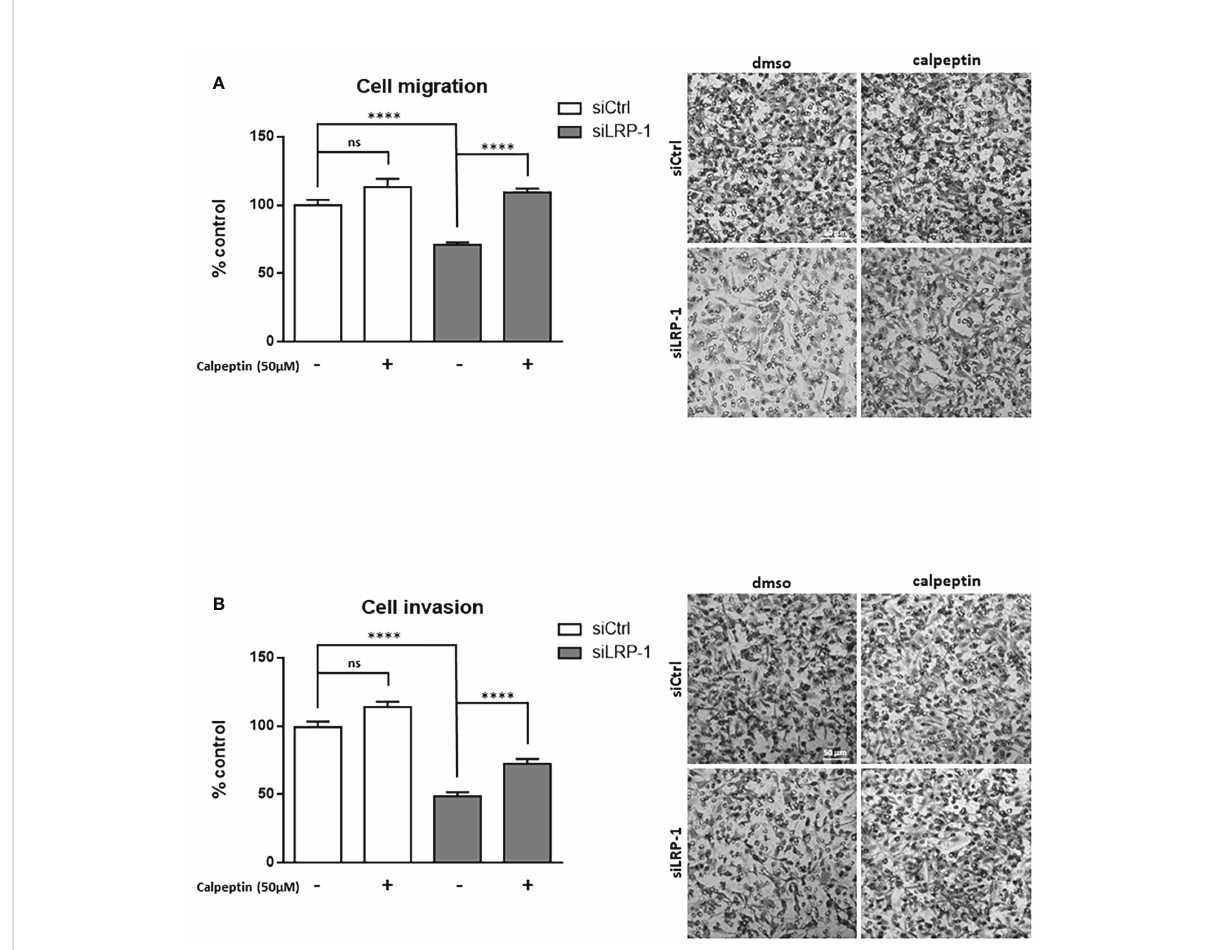
FIGURE 2 LRP-1-mediated control of calpain activity contributes to carcinoma cells migratory and invasive properties. Cell migration and invasion assays were carried out with FTC133 cells transfected with siRNA sequences, treated with 50 µM calpeptin or vehicle. Three-dimensional cell migration was assessed by using uncoated Transwell fi lters (A) . Tumor cell invasion was measured on Matrigel-coated Transwell membranes (B) . Representative images are shown. Migration and invasion were determined by counting cells in eight random microscopic fi elds per well. Results are expressed as mean ± sem after normalization by comparison with siCtrl transfected cells set to 100%, from at least four distinct experiments each performed in triplicate. ns, not signi fi cant; ****, P <